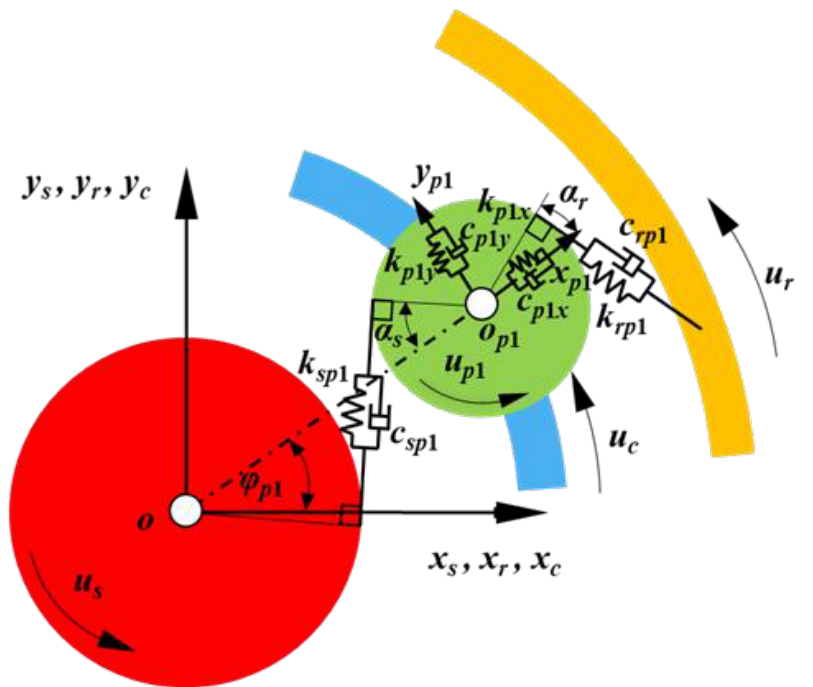
Figure 7. Gear mesh model of the PGS.